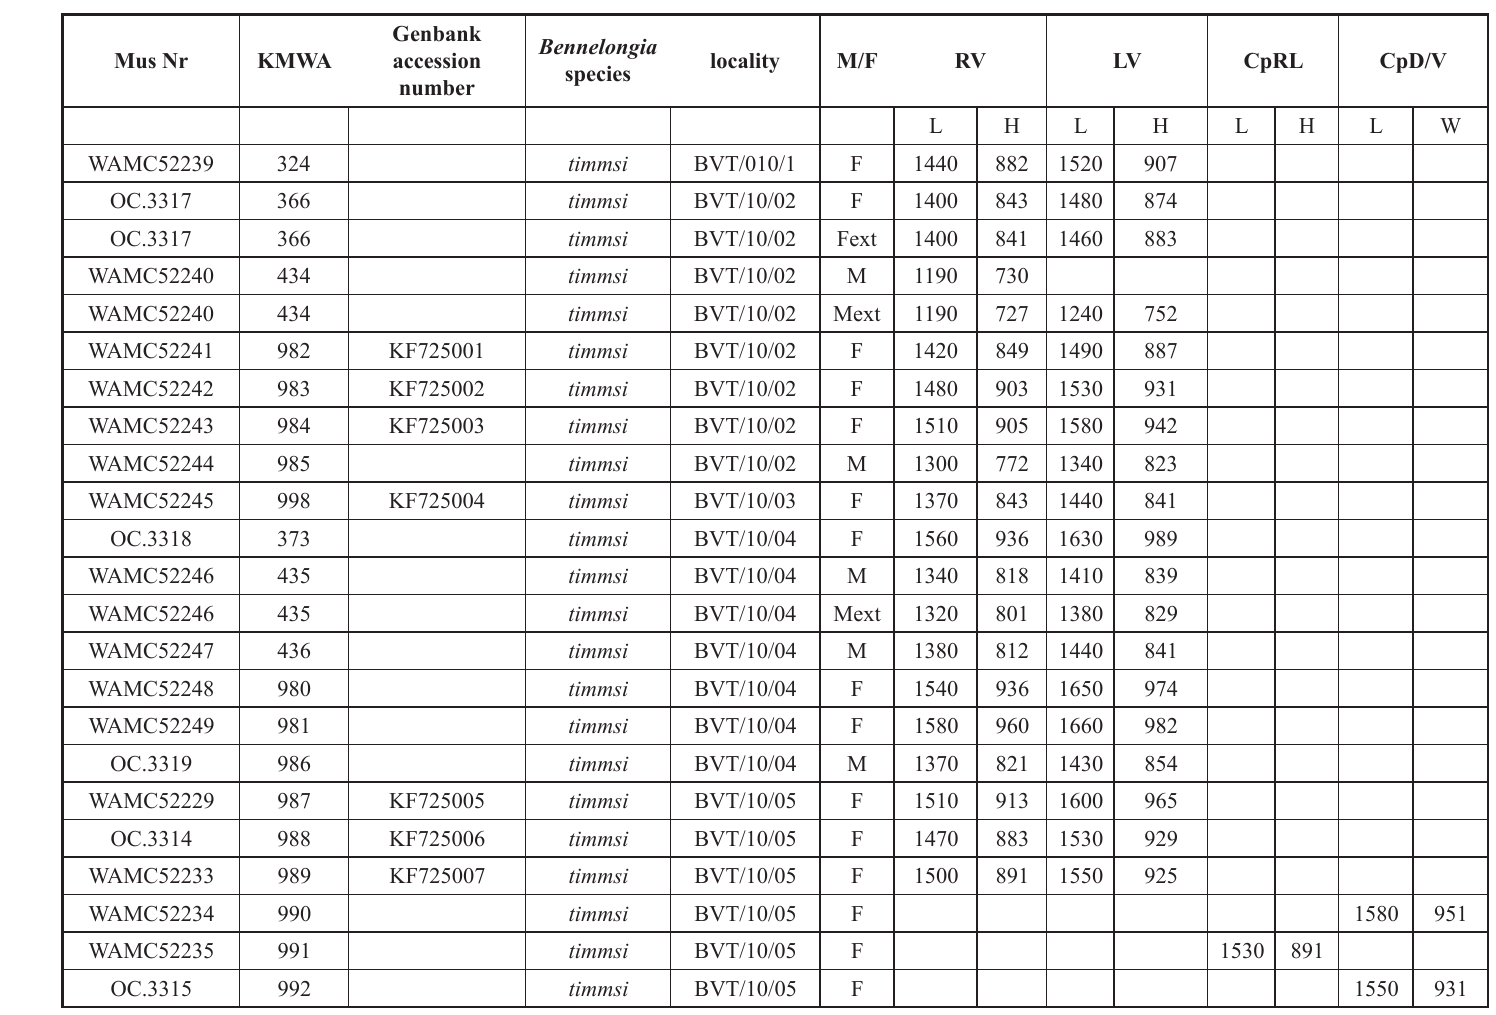
Table 1. Individual measurements of specimens used for the present descriptions. all measurements were done using seM (see Material and methods). If a molecular sequence was available for the same specimen, the GenBank registration number is also given. However, some specimens were used as whole animals for Dna sequencing, and thus no measurements are available. the present table therefore does not list all 99 specimens for which sequences are available. specimens in bold are